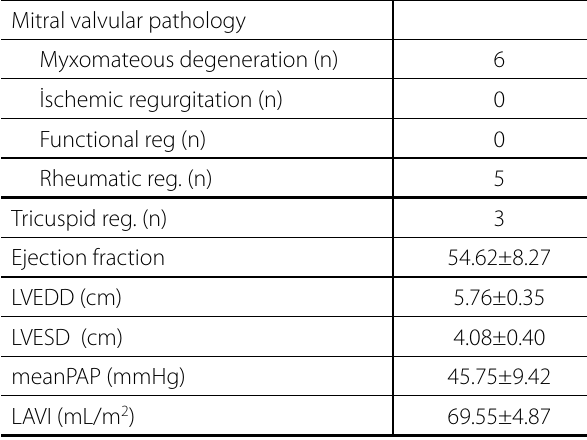
Table 2 . Echocardiography datas.